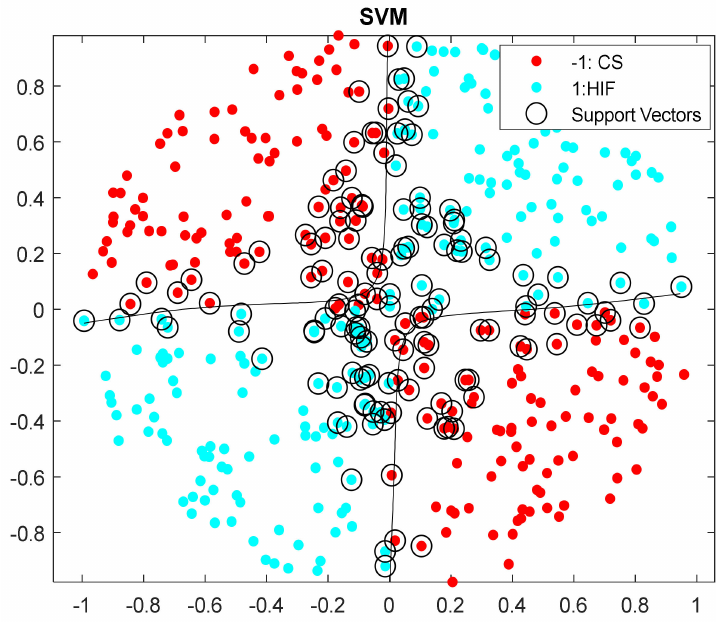
Figure 7. SVM classification between HIF and CS.